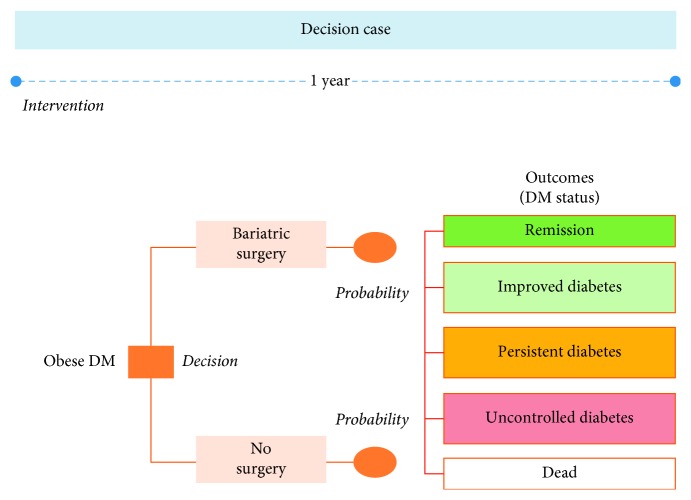
Decision tree model.